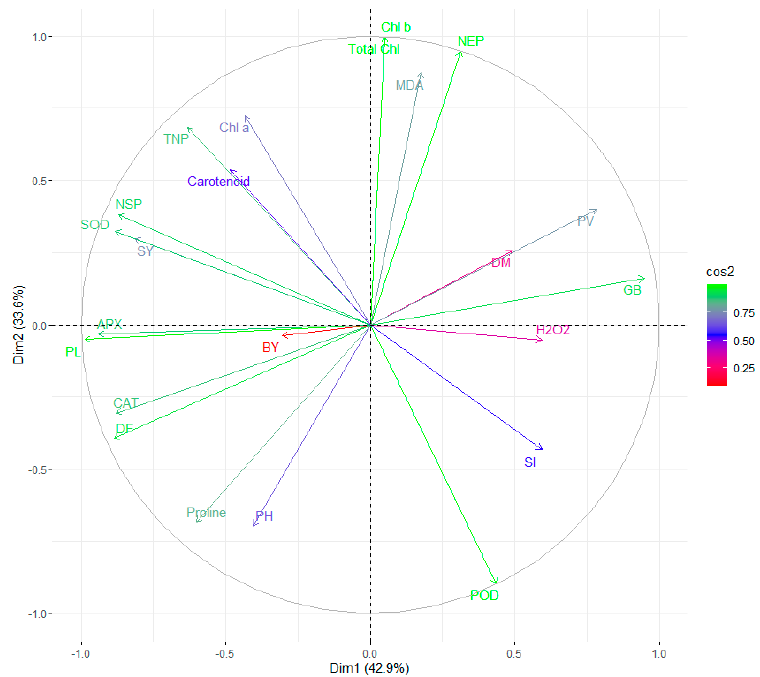
Figure 14. Biplot of different characters of field pea using PC1 and PC2 under non-stress condition.